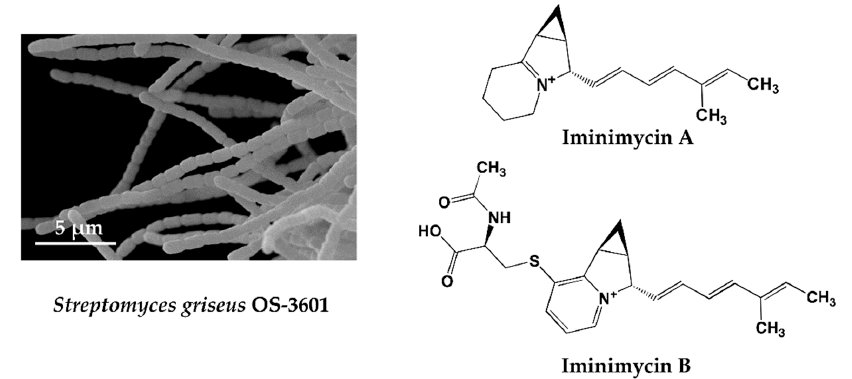
Figure 1. Scanning electron micrograph of the aerial spore chain of the streptomycin-producing strain Streptomyces griseus OS-3601 ( Left ) and structures of iminimycin A and B discovered from the culture broth ( Right